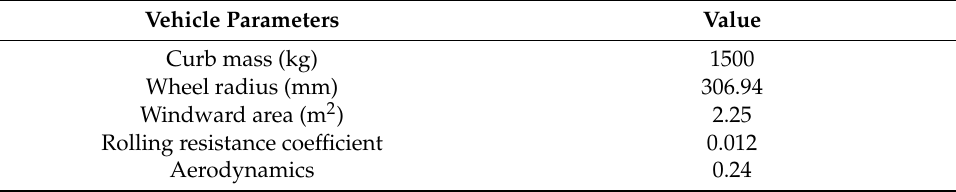
Table 3. Main vehicle parameters of the PHEV